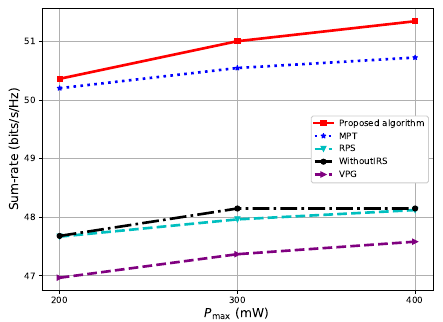
Figure 5. The network sum-rate versus the maximum transmit power, P max